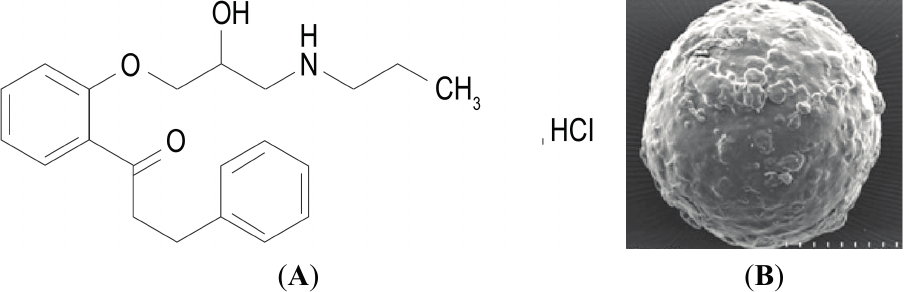
Figure 1. The structure of propafenone hydrochloride ( A ); and transmission electron microscope photograph of propafenone hydrochloride (PPF) ( B ). Magnification: 5000×, Scale bar = 500